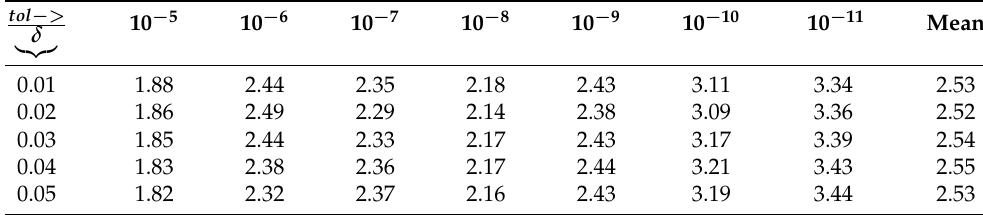
Table 6. Efficiency measures ratios of DLMP6(5) vs. NEW6(5) for perturbed Kepler in [ 0,20 π ] .